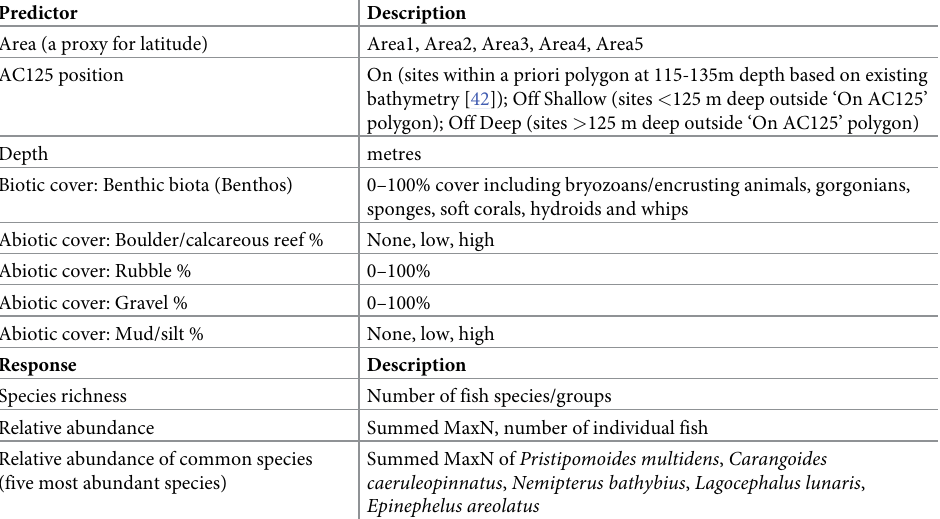
Table 1. Spatial and habitat predictors and responses used in analyses of marine communities along the desig- nated